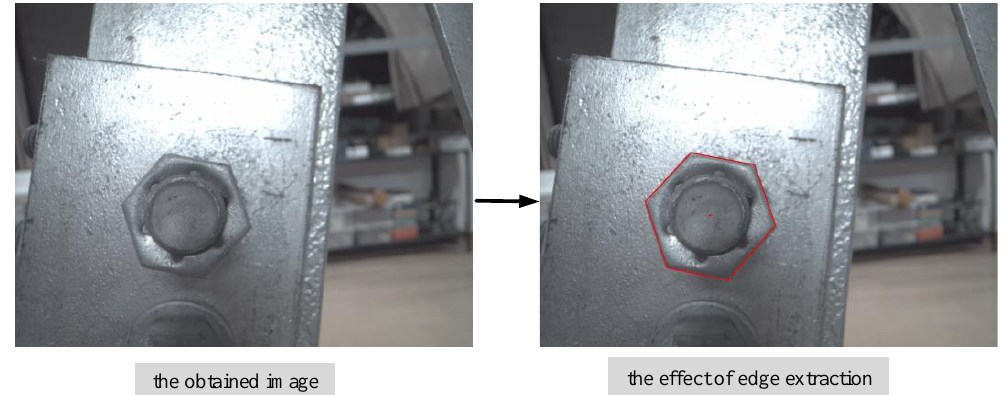
Figure 16. Bolt edge feature extraction.